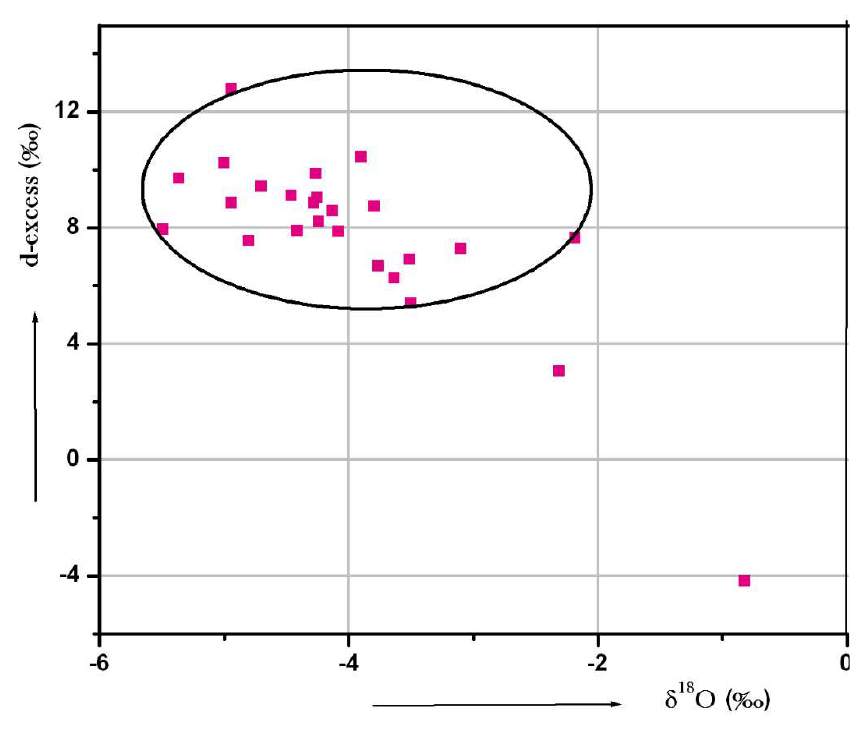
Figure 13. Plot for d-excess versus δ 18 O.